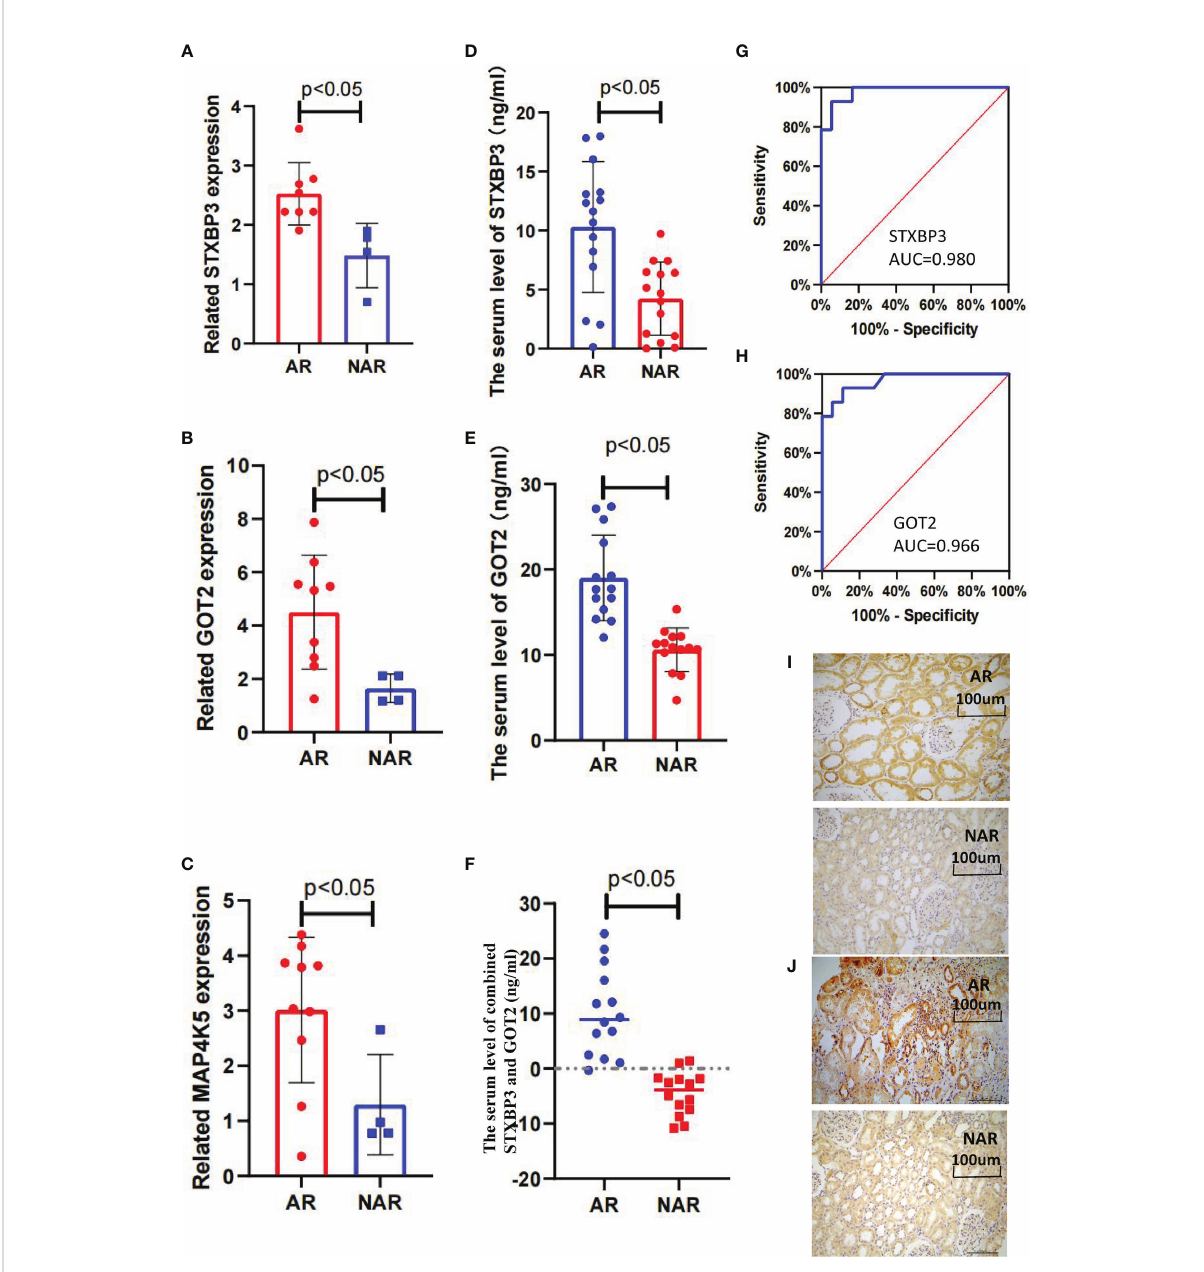
FIGURE 5 Validation of three key DEGs with RT-qPCR, ELISA, and IHC staining. (A – C) STXBP3, GOT2, and MAP4K5 expression was measured in 10 healthy controls, four patients with without AR episodes (NAR), and 10 patients with acute rejection (AR). (A) The expression of STXBP3 was compared between healthy controls, patients with NAR, and patients with AR (n=24). (B) The expression of GOT2 was compared between healthy controls, patients with NAR, and patients with AR (n=24). (C) The expression of MAP4K5 was compared between healthy controls, patients with NAR, and patients with AR (n=24). (D – F) ELISA validation of STXBP3 and GOT2 expression in four patients with NAR and 10 patients with AR. (G, H) ROC curve was constructed to estimate the diagnostic power of STXBP3 and GOT2 for early AR. STXBP3: AUC = 0.989 (p < 0.0001), cut- off value = 7.840, sensitivity: 0.929, speci fi city: 0.944; GOT2: AUC = 0.966 (p < 0.0001), cut-off value = 13.147, sensitivity: 0.929, speci fi city: 0.889; and the combination of STXBP3 and GOT2: AUC = 1.000(p < 0.0001). (I, J) Immunohistochemical staining of kidney tissues showed that both STXBP3 and GOT2 were increased in AR group compared with that in NAR group. The scale bars in i – j = 100 m